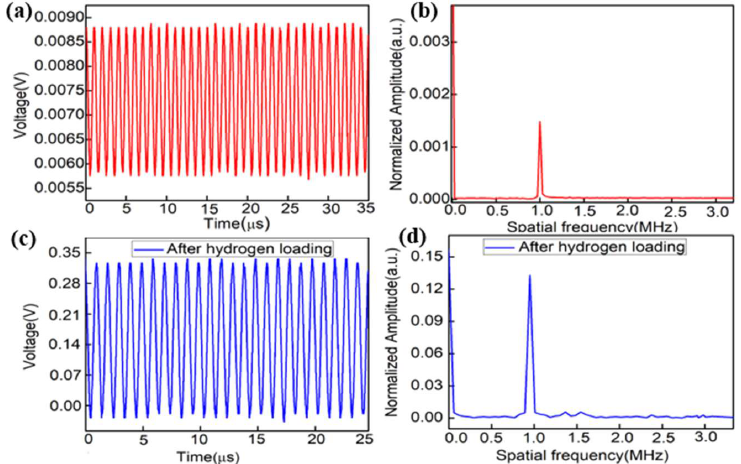
Figure 7. Response to ( a ) a 1-MHz continuous sinusoidal signal without hydrogen loading and ( b ) frequency spectrum, ( c ) a 1-MHz continuous sinusoidal signal with hydrogen loading and ( d ) frequency spectrum.